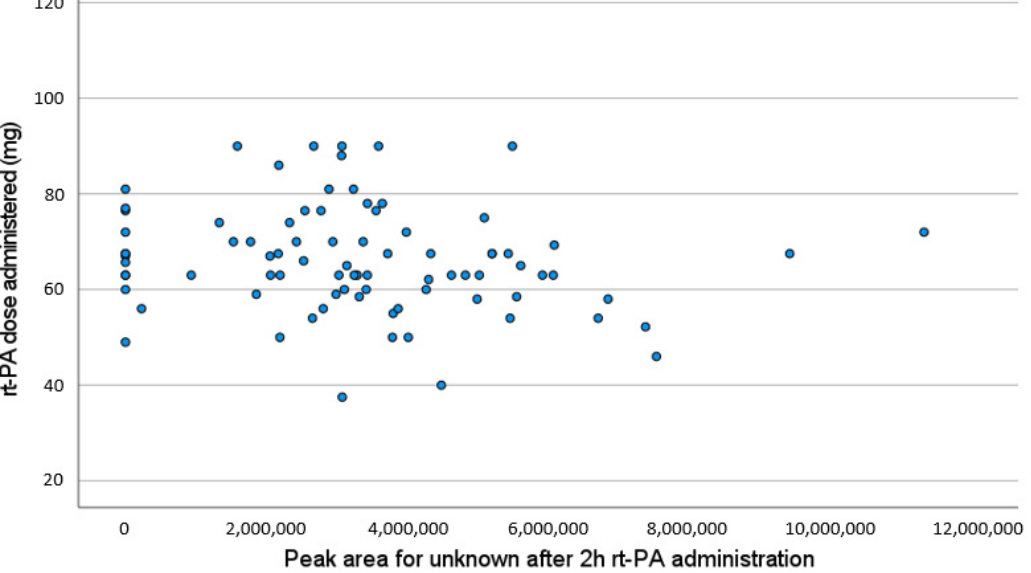
Figure 3. Correlation plot between the amount of new compounds detected and the administered dose of rt-PA (r = − 0.178, p = 0.103).